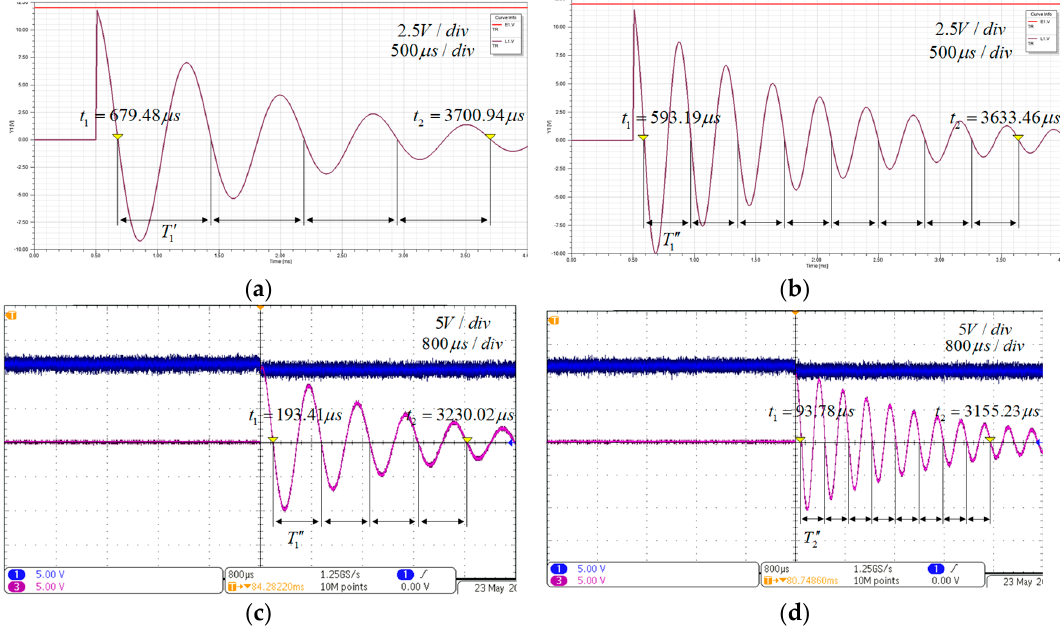
Figure 9. The simulation and experiment waveforms. ( a ) the simulation waveform with C 0 + C 1 = 2 µ F, ( b ) the simulation waveform with C 1 = 0.51 µ F, ( c ) the experiment waveform with C 0 + C 1 = 2 µ F, ( d ) the experiment waveform with C 1 = 0.51 µ